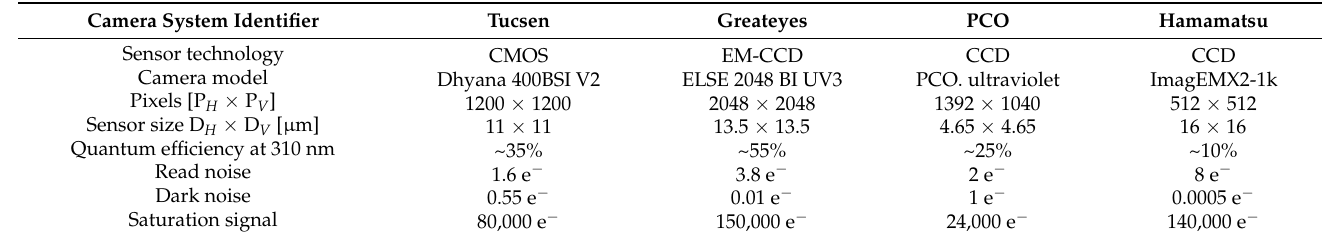
Table 1. Camera properties used in the instrument intercomparison experiment.